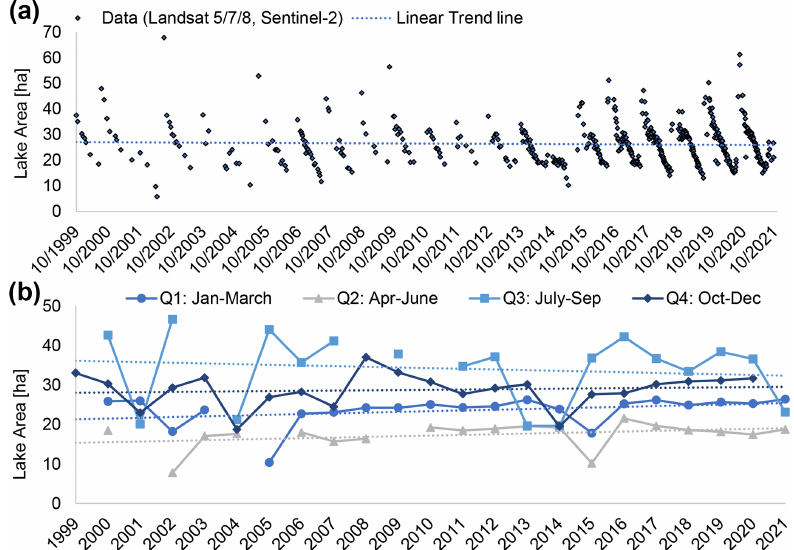
Figure A1. (a) Time series of Lac Kononi surface water area retrieved from Landsat 5, 7, and 8 as well as Sentinel-2 optical satellite imagery for the period 1 October 1999 until 30 September 2021 along with the linear trend line. (b) Annual average quarterly lake areas and associated linear trend lines. The location of Lac Kononi is indicated in Fig.